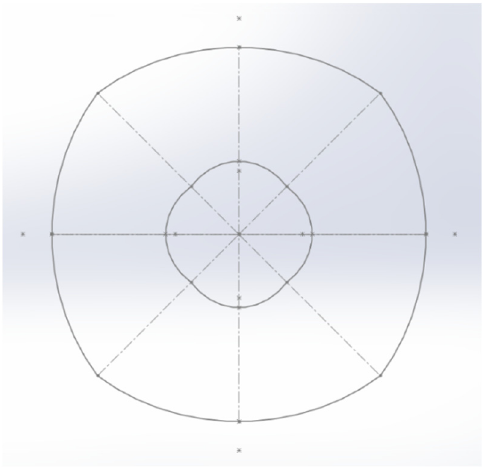
Figure 4. Representation of the resulting section of the workspace.